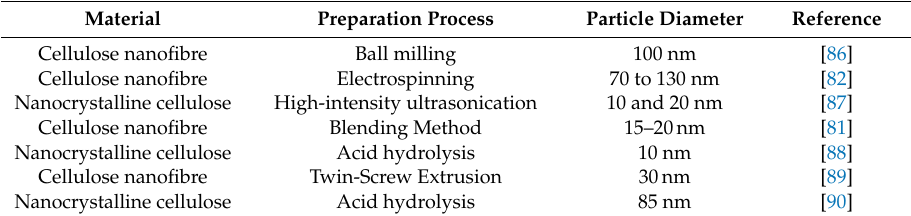
Table 4. Nanocellulose material preparation technique.